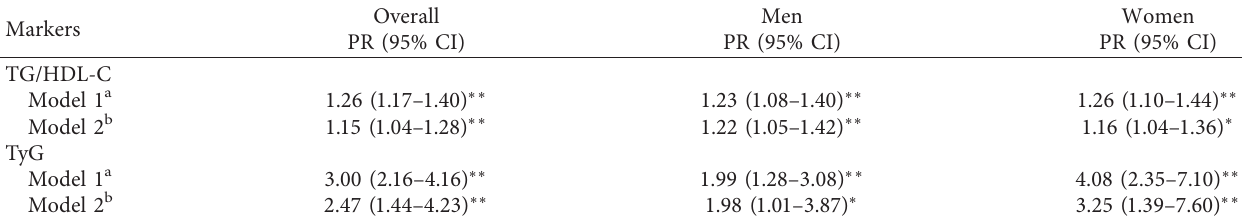
Table 3: Prevalence ratio and 95% CIs for lifetime cardiovascular risk according to levels of insulin resistance indexes.